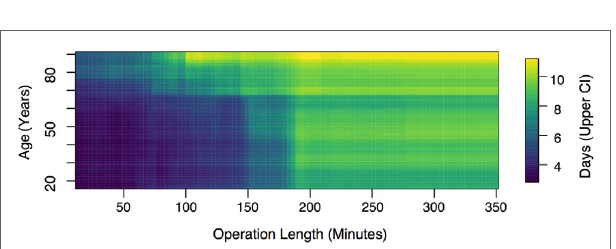
FiGure 2 | upper 95% confidence interval of predicted stay duration . This figure shows that while, for younger patients, the effect of surgery length on length of stay is relatively weak up to the 3-h mark, for older patients ( > 55 years), stay duration increases strongly with duration length across all time scales.